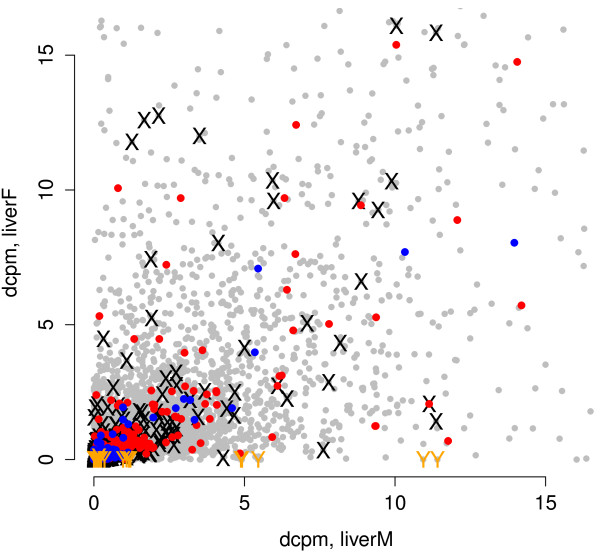
Sexually dimorphic gene expression. Differences in gene expression (in liver) between the two individual chimpanzees. The x-axis represents expression values (in dcpm) in the female and the male is on the y-axis; each grey dot represents the expression of one gene. Genes located on the sex chromosomes are displayed as × and Y, respectively. Overlaid are data from Blekhman et al. [21] with red dots indicating genes with higher expression in female than in liver, and blue dots representing the opposite scenario.